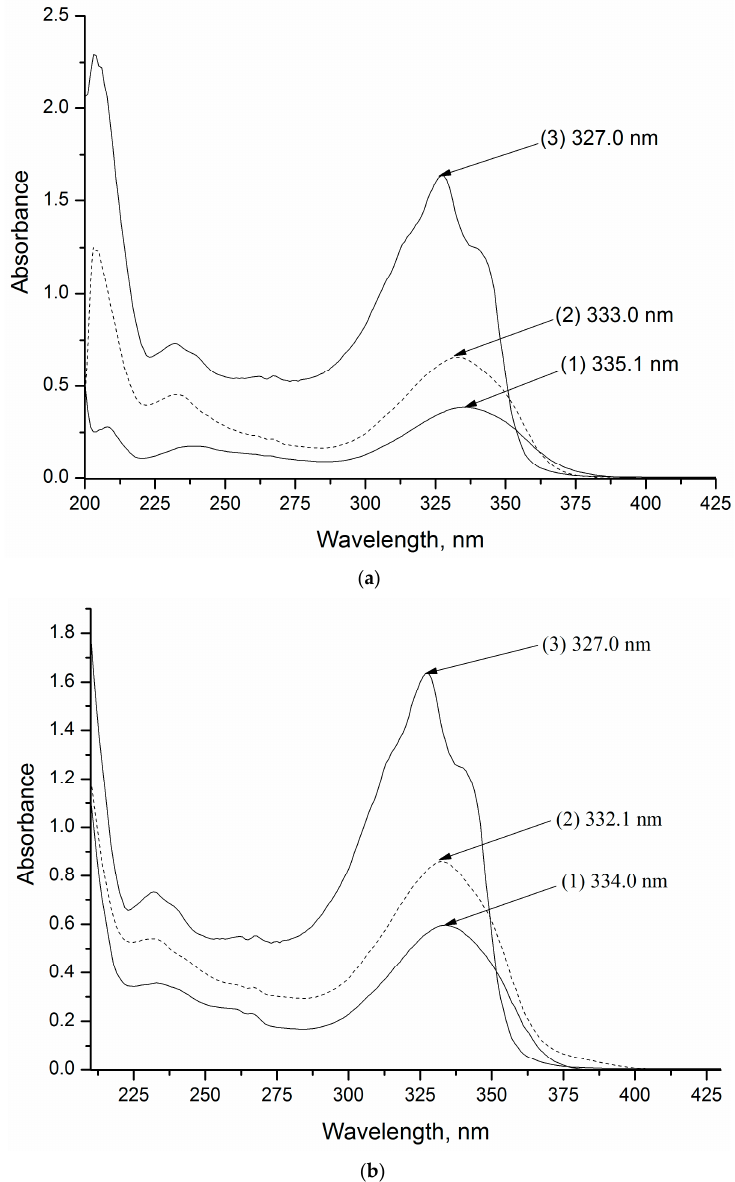
Figure 2. The absorption spectra of RS-186 in pure buffer (1), with 0.05 M 2-HP- β - CD (2) and n-hexane (3); pH 2.0—( a ), pH 7.4—( b ). Solid lines mean the spectra of pure solvents; dashed lines indicate the spectra of aqueous 2-HP- β - CD solutions.